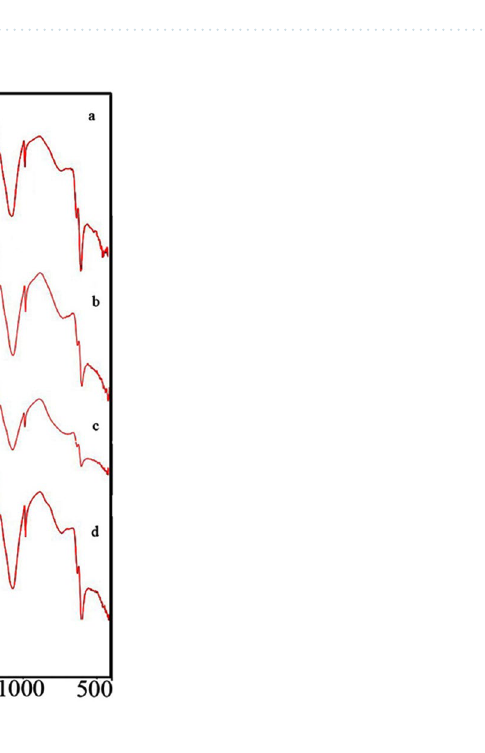
Figure 5. FT-IR of ( a ) Cu-BaSO 4 –BaTiO 3 , ( b ) Fe–BaSO 4 –BaTiO 3 , ( c ) N–BaSO 4 –BaTiO 3 and ( d ) S–BaSO 4 –